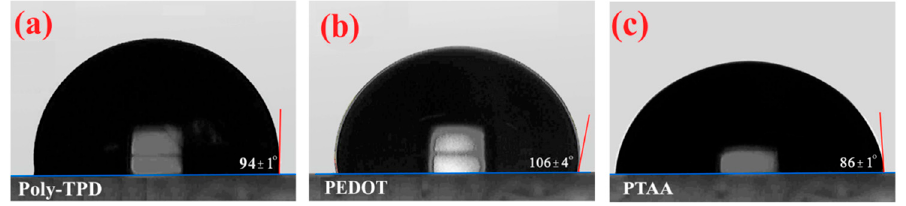
Figure 3. Water contact angle of the p-type polymer films of interest: Poly-TPD ( a ), PEDOT ( b ), and PTAA ( c ).